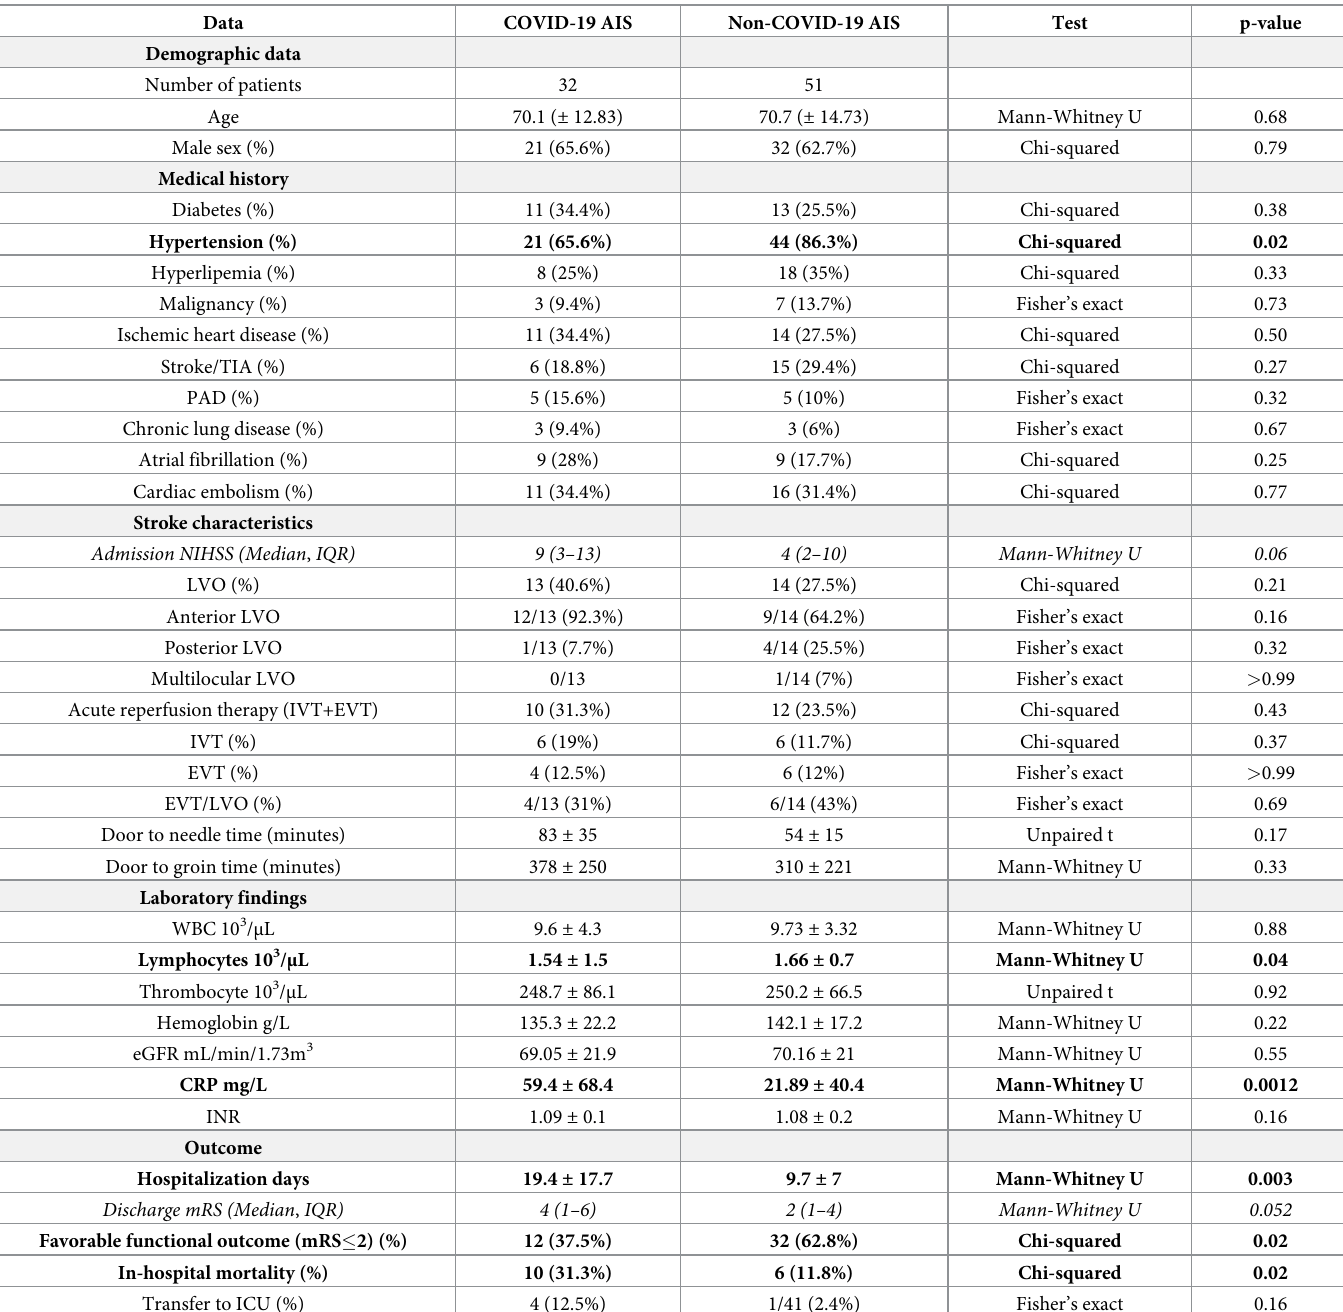
Table 1. Comparing characteristics of COVID-19 AIS with non-COVID-19 AIS